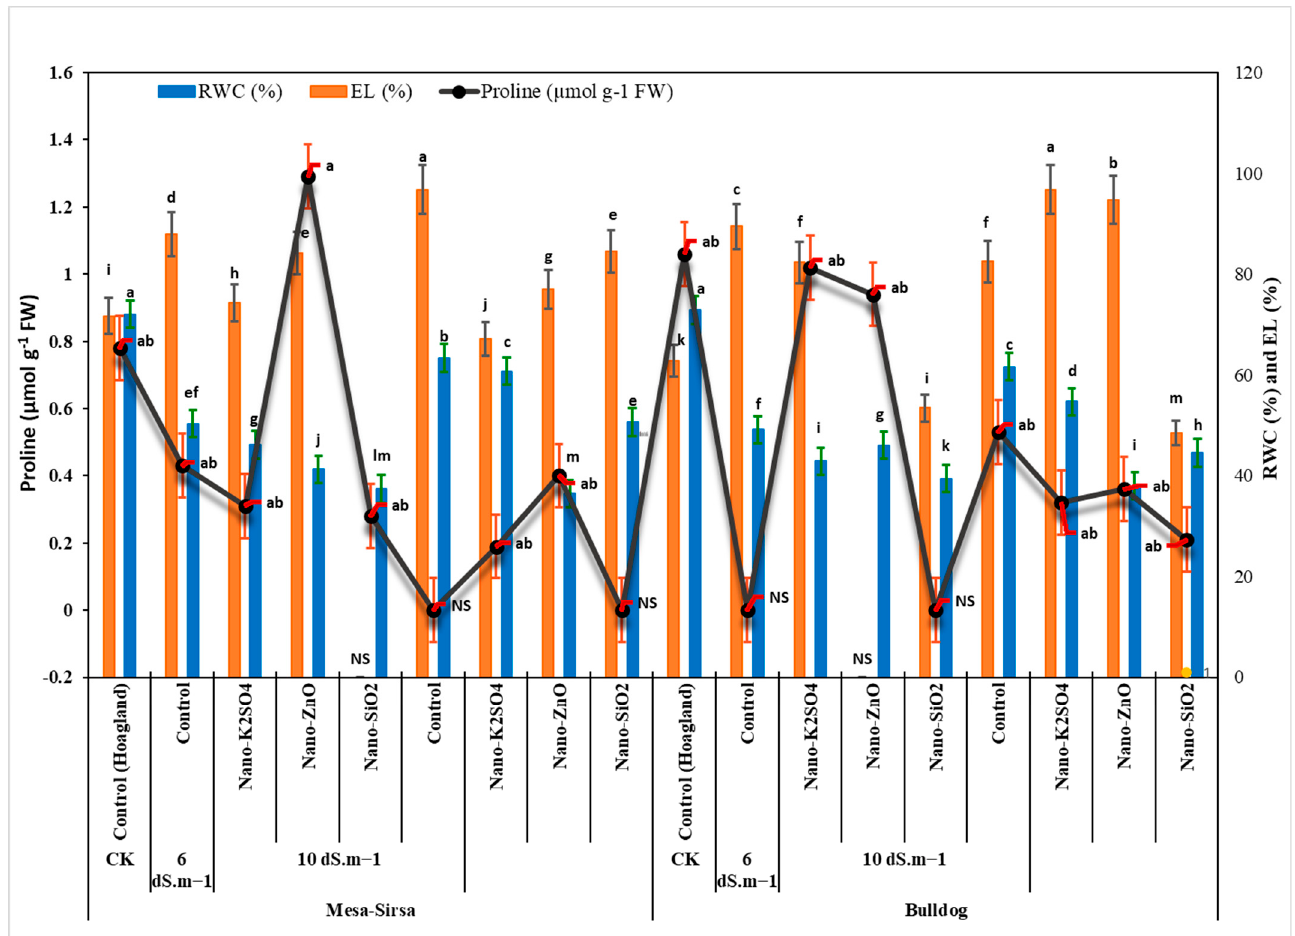
Figure 1. Effect of different Nano-fertilizers (K 2 SO 4 , ZnO, and SiO 2 ) on Relative Water Content (RWC), Electrolyte Leakage (EL), and Proline content to Alfalfa genotypes grown under three salt levels (control “Hoagland”, 6 and 10 dSm − 1 ). NS: no sample. The column values with the same letters are statistical similar according to Duncan Multiple Range Test (DMRT) at p <